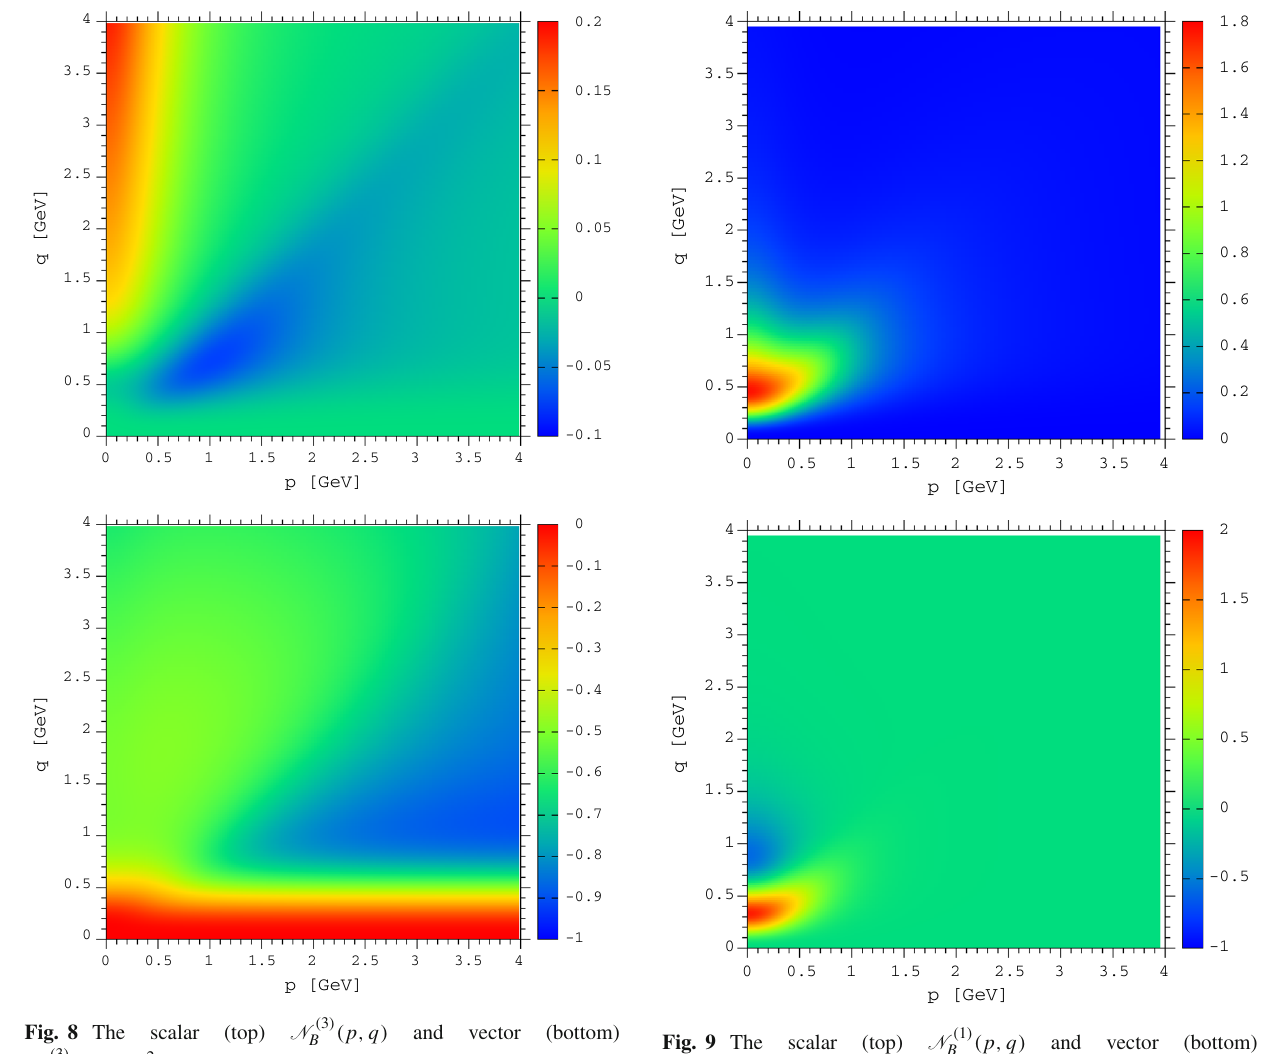
( p , q ) and vector (bottom) B